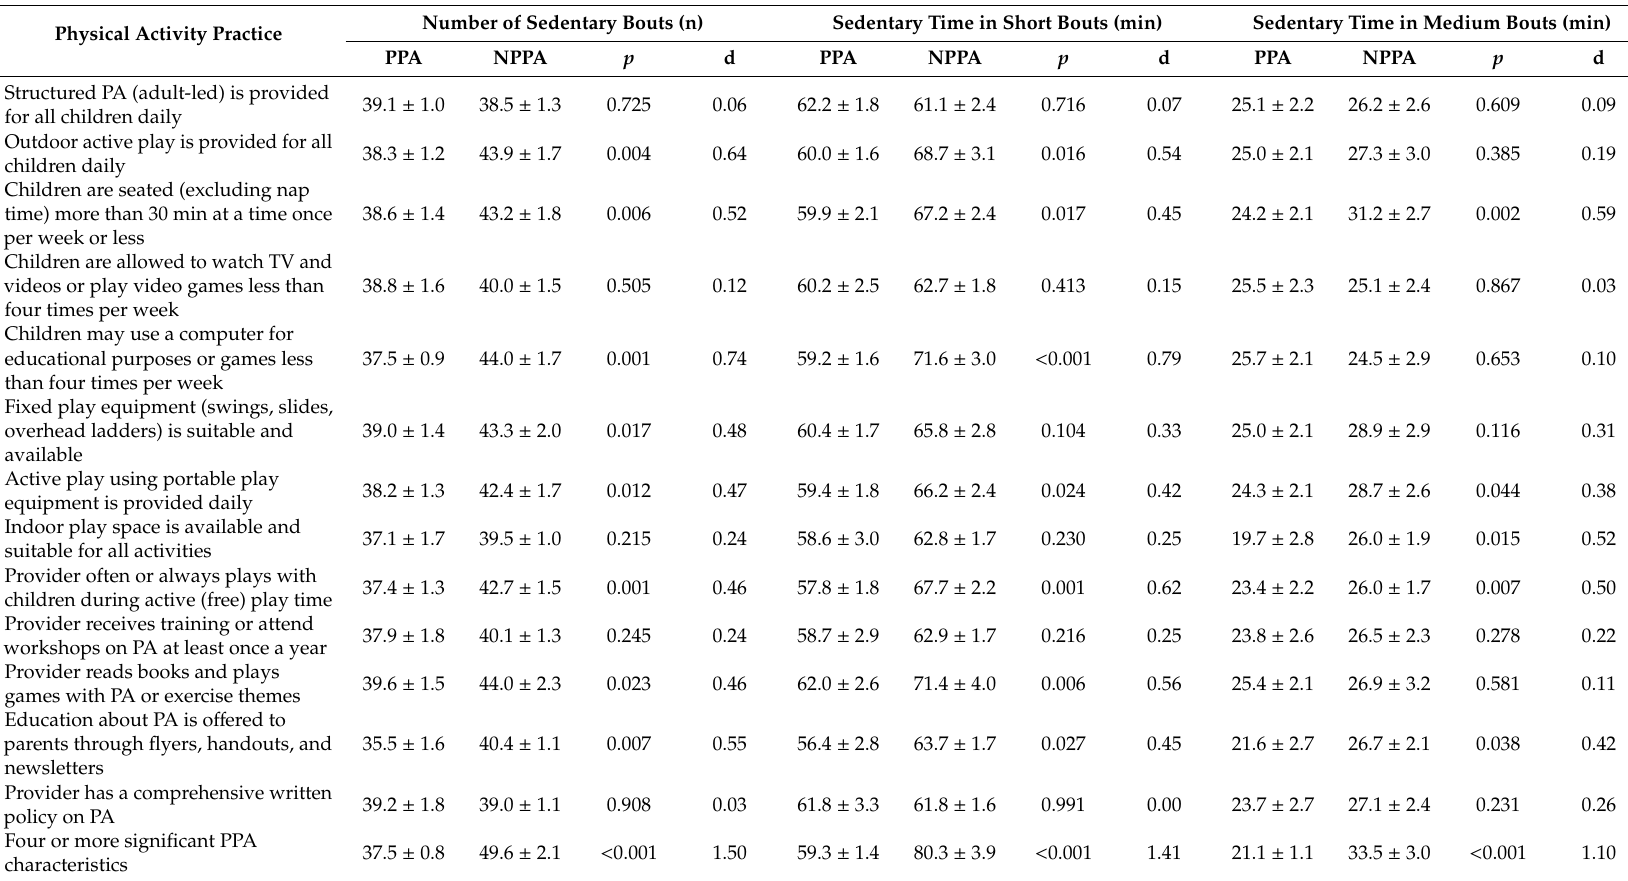
Table 3. Comparison of number of sedentary bouts and sedentary time in short and medium bouts in FCCHs classified as PPA vs. non-PPA. Number of Sedentary Bouts (n) Sedentary Time in Short Bouts (min) Sedentary Time in Medium Bouts (min) Physical Activity Practice PPA NPPA p d PPA NPPA p d PPA NPPA